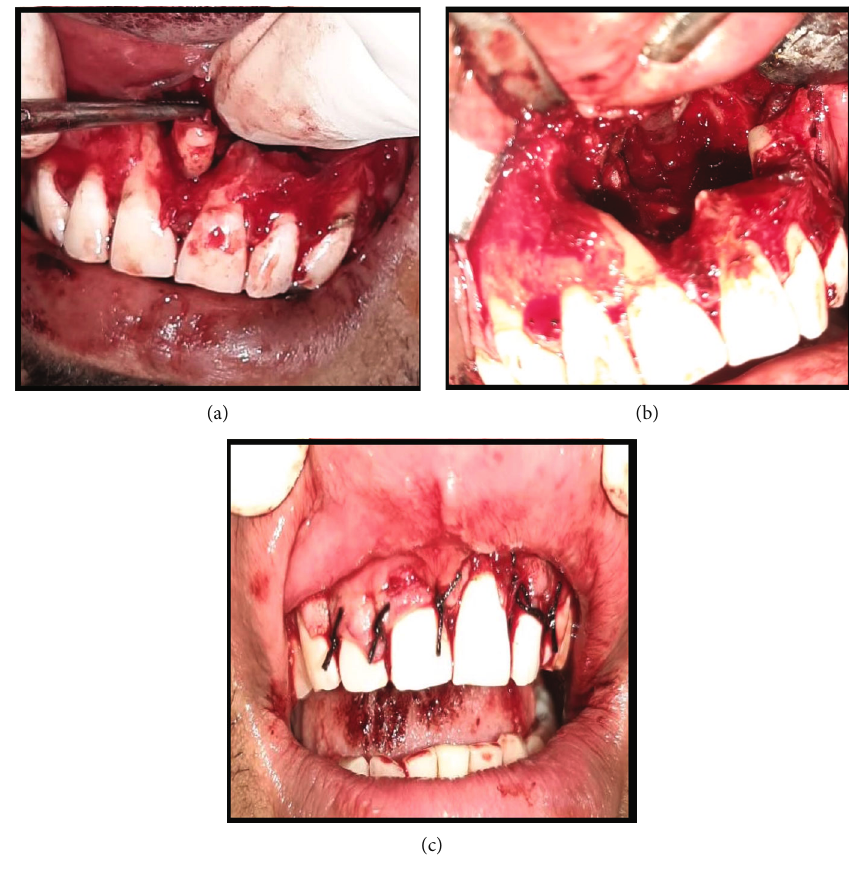
Figure 3: (a) – (c) The surgical enucleation of the lesion.